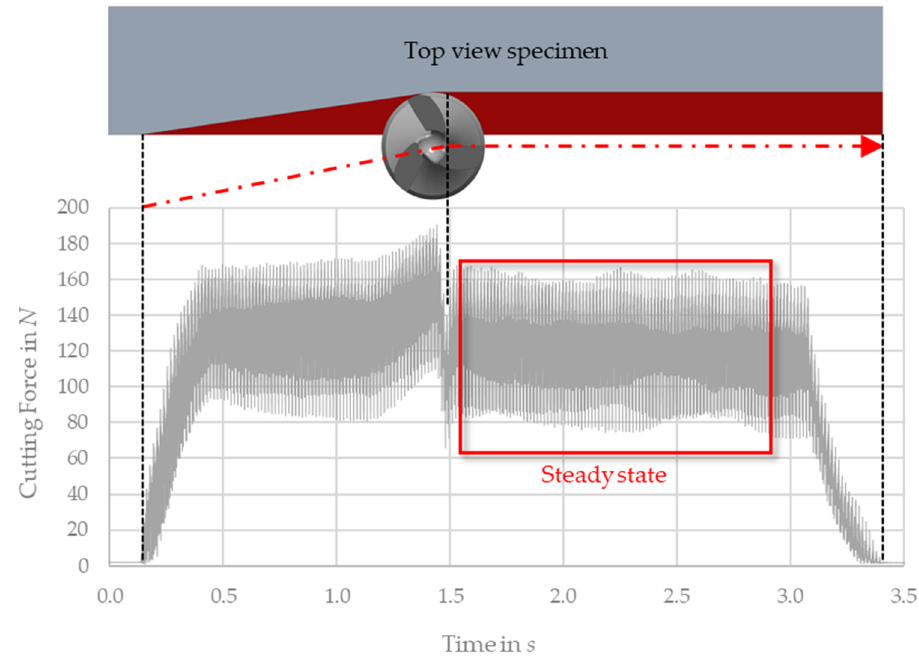
Figure 11. Exemplary representation of the milling force during the machining (3DPMD).